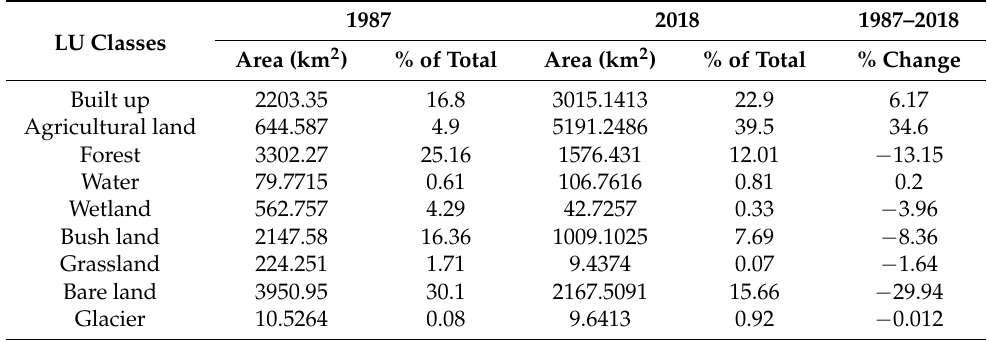
Table 3. Losses/gains in land use/cover